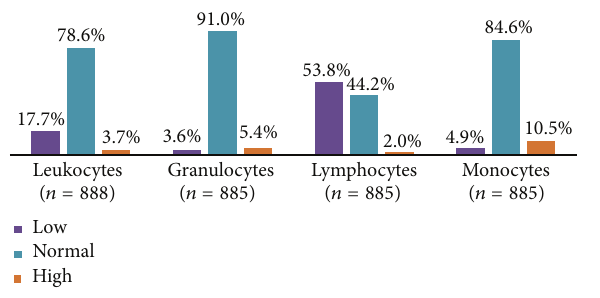
Figure 2: Leukocyte counts distributions.